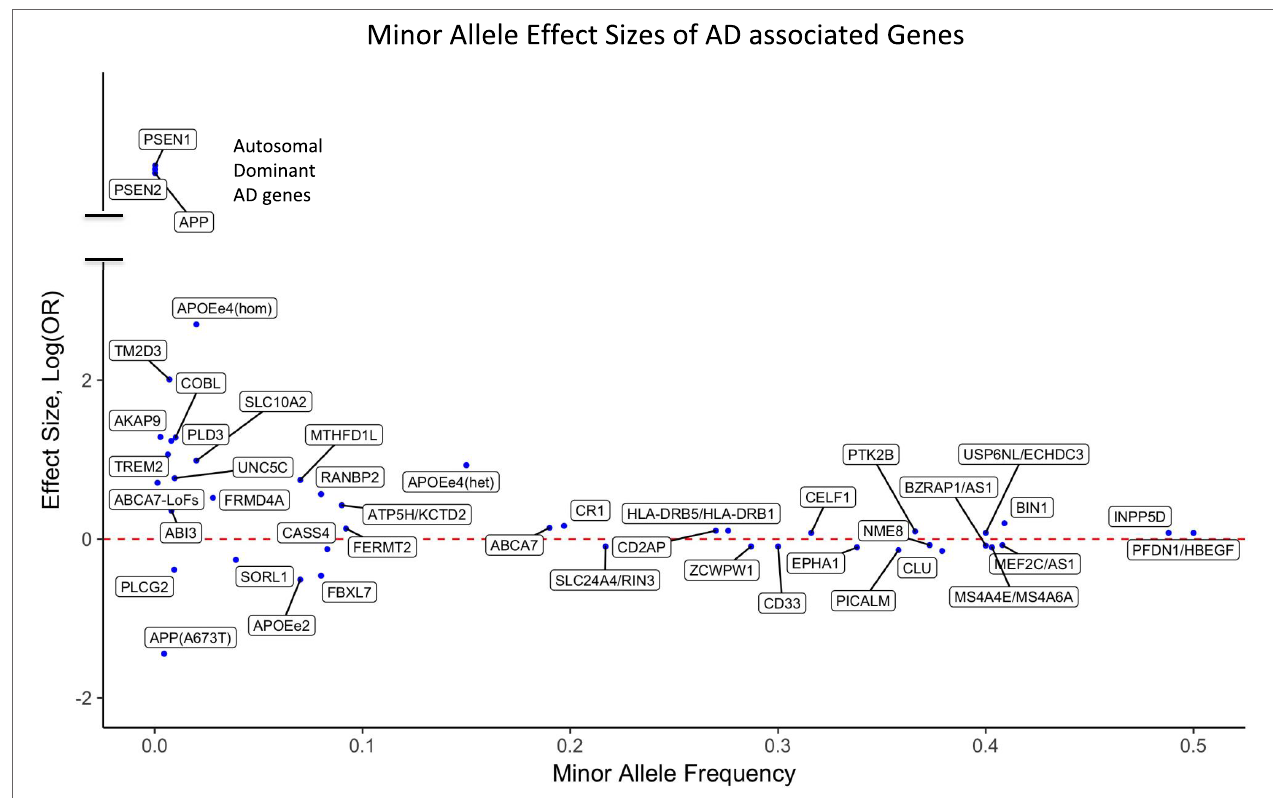
FiGURe 1 | Effect sizes of AD associated variants for the respective minor alleles. The red dotted line indicates OR = 1 [log(OR) = 0]. Minor alleles with log(OR) above the line are risk alleles and below the line are protective. Abbreviations: APOEe4(hom), homozygosity for the APOE4 allele; APOEe4(het), heterozygosity for the APOE4 allele; ABCA7-LoFs, aggregated effects of loss-of-function variants in ABCA7; OR, odds ratio; AD, Alzheimer’s